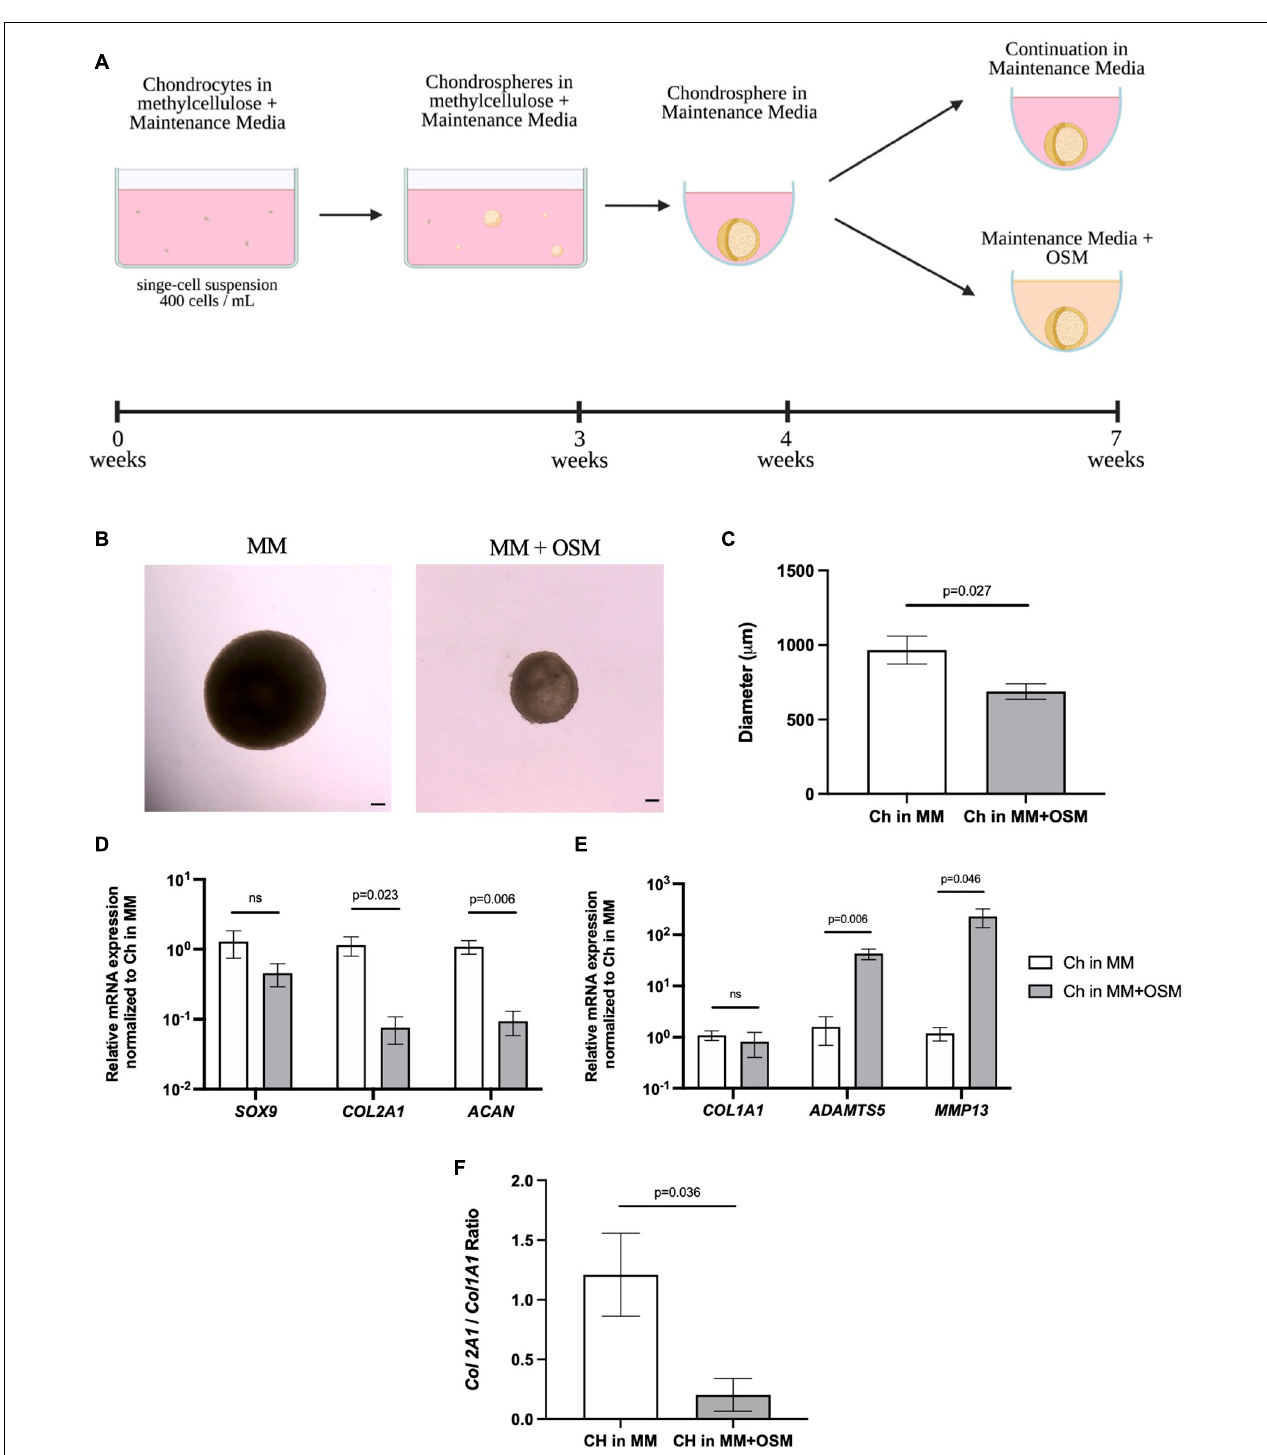
FIGURE 9 | Porcine articular chondrospheres degrade and upregulate catabolic genes in response to pro-inflammatory stimuli. (A) Schematic and timeline of MC with MM culture method and introduction of pro-inflammatory cytokine OSM at 4 weeks. (B) Representative images of a pig articular chondrospheres in liquid MM alone (left) or liquid MM + OSM (right) after 3 weeks exposure, scale bar = 100 µ m. (C) Average diameter of chondrospheres cultured in liquid MM or MM + OSM. (D) qPCR of anabolic genes after normalizing expression to chondrospheres cultured in MM alone, n = 4 biological replicates. (E) qPCR of catabolic genes after normalizing expression to chondrospheres cultured in MM alone, n = 4 biological replicates. (F) Collagen II/Collagen I ratio for chondrospheres in MM alone versus MM + OSM, n = 4 biological replicates. All data are represented as mean ± SEM and p -value calculated using an unpaired t -test.